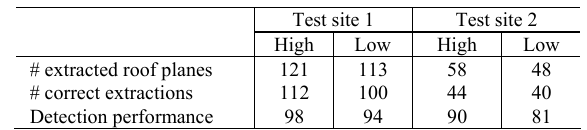
81 Figure 10: Gaps due to less number of points is solved (left) and error due to missing data on a flat roof